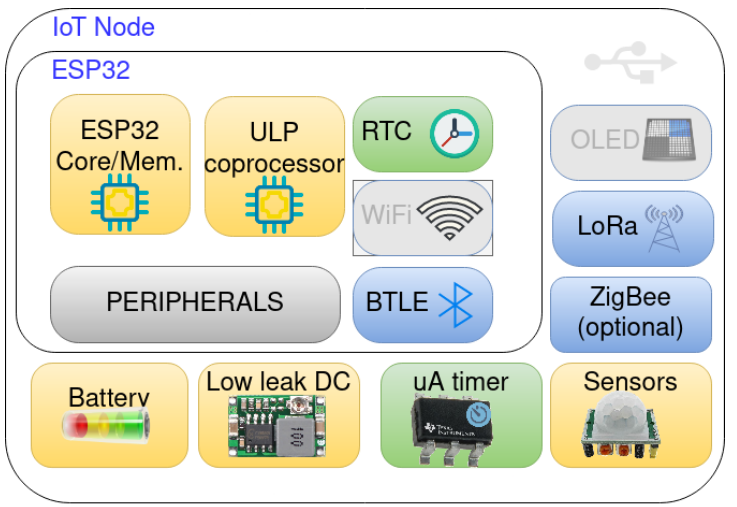
Figure 5. IoT node